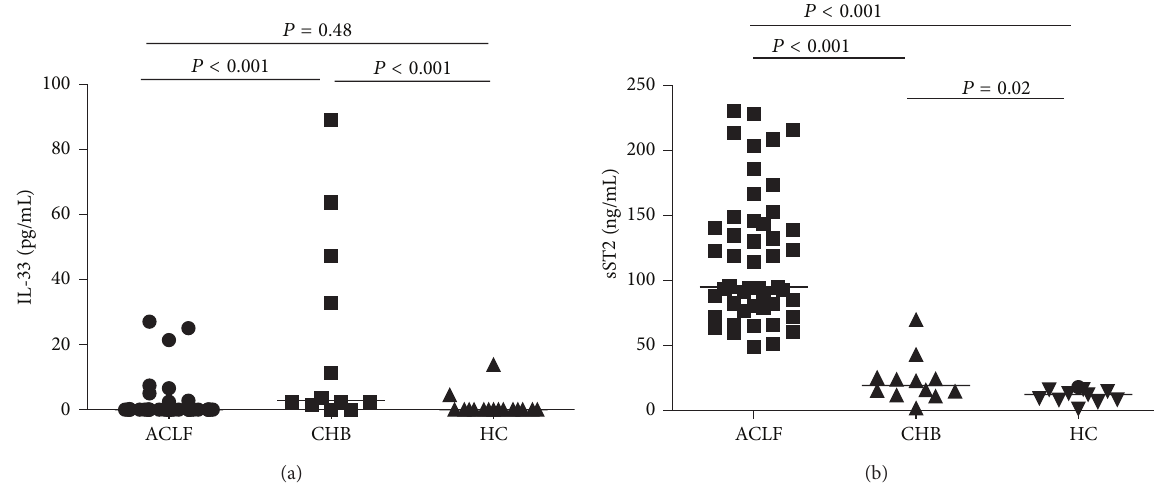
Figure 1: Baseline plasma levels of IL-33 and soluble ST2 (sST2). Individual data points represent mean values of patients with hepatitis B-related acute-on-chronic liver failure (HBV-ACLF, 𝑛 = 48 ), patients with chronic hepatitis B (CHB, 𝑛 = 12 ), and healthy controls (HC, 𝑛 = 16 ). Horizontal lines indicate median values of each group. (a) Baseline plasma levels of IL-33 were determined using Luminex xMAP technology. (b) Baseline plasma sST2 levels were determined by ELISA. Differences between two groups were evaluated using the Mann-Whitney 𝑈 test. Table 2: Baseline characteristics of HBV-ACLF patients who survived during the 180-day follow-up and those who died.